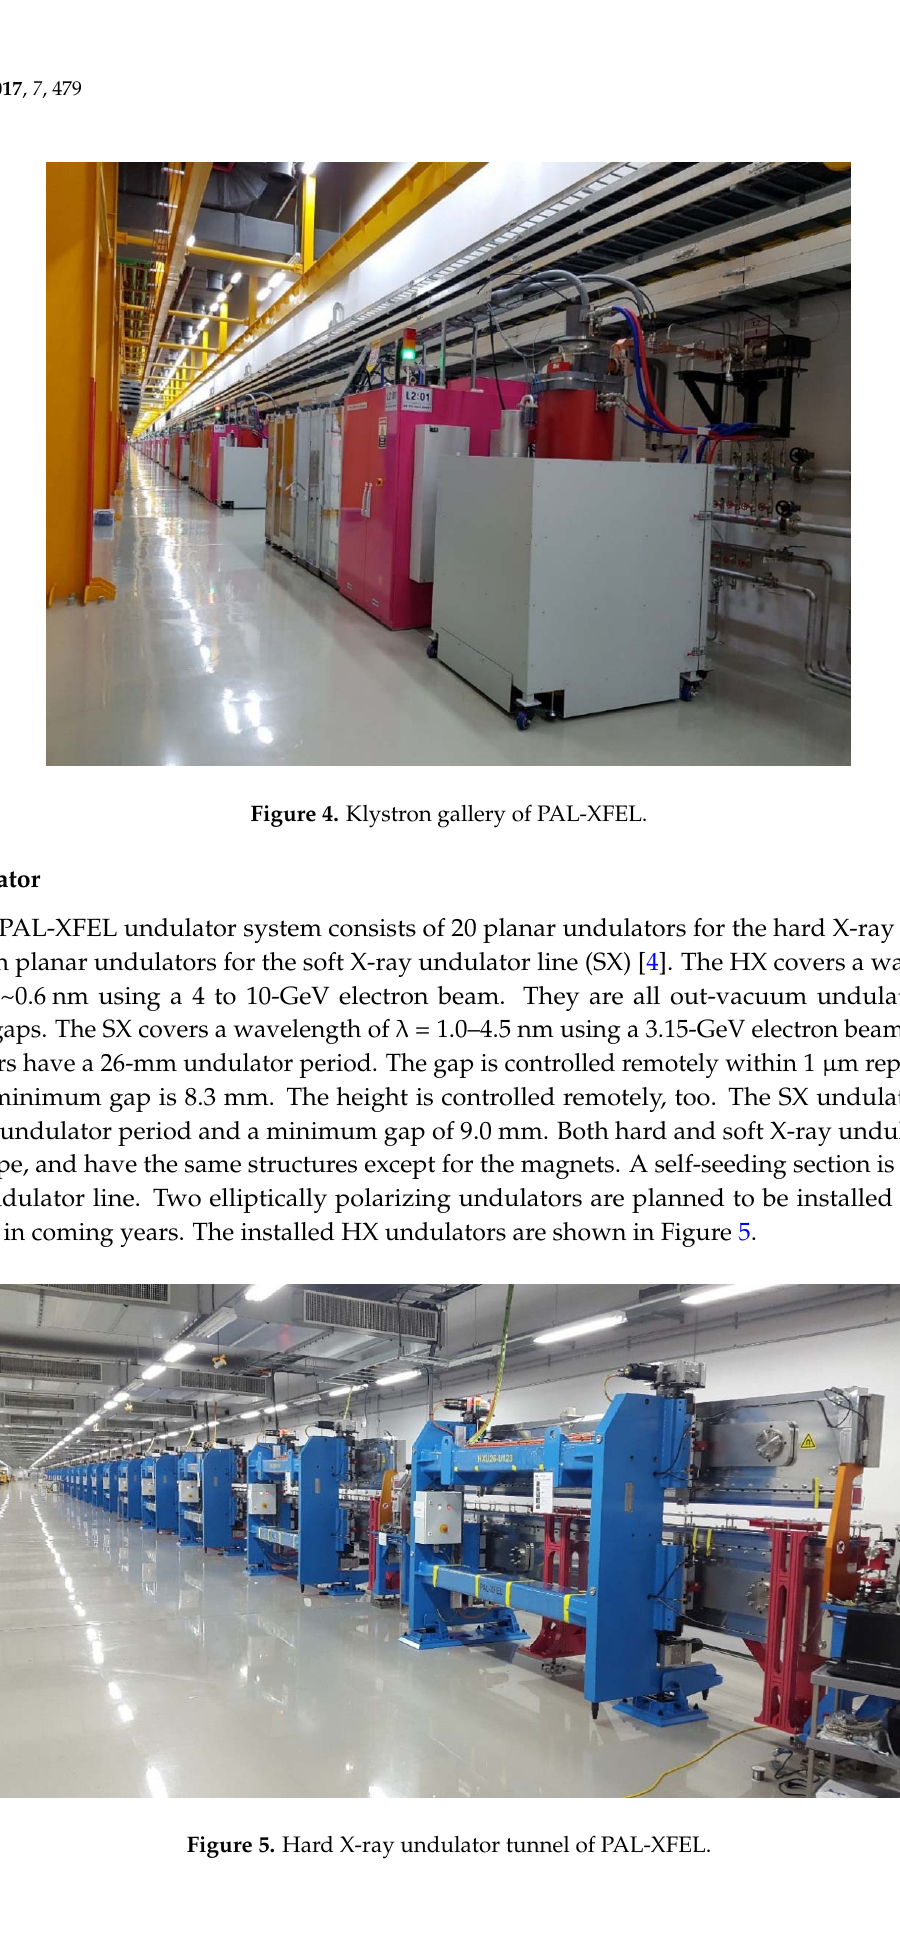
Figure 5. Hard X ‐ ray undulator tunnel of PAL ‐ XFEL. Figure 5. Hard X-ray undulator tunnel of